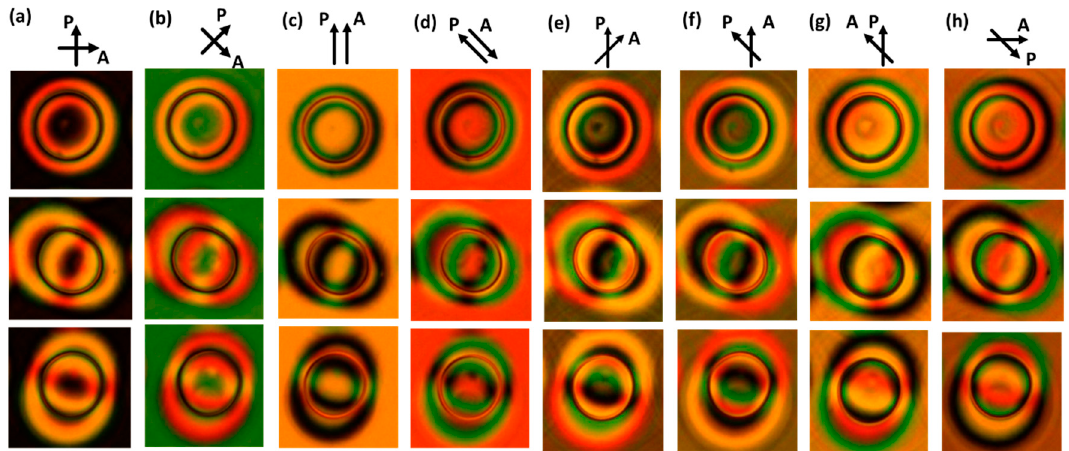
Figure 5. Microscope images for different orientations of the polarizers. Three different structures are shown, all with dimensions of the patterned rings r out = 50 µm (r in = 0.4 * r out ): one structure with overlap between the centra of the patterned rings at the top and bottom substrate and two structures with shifted centra.